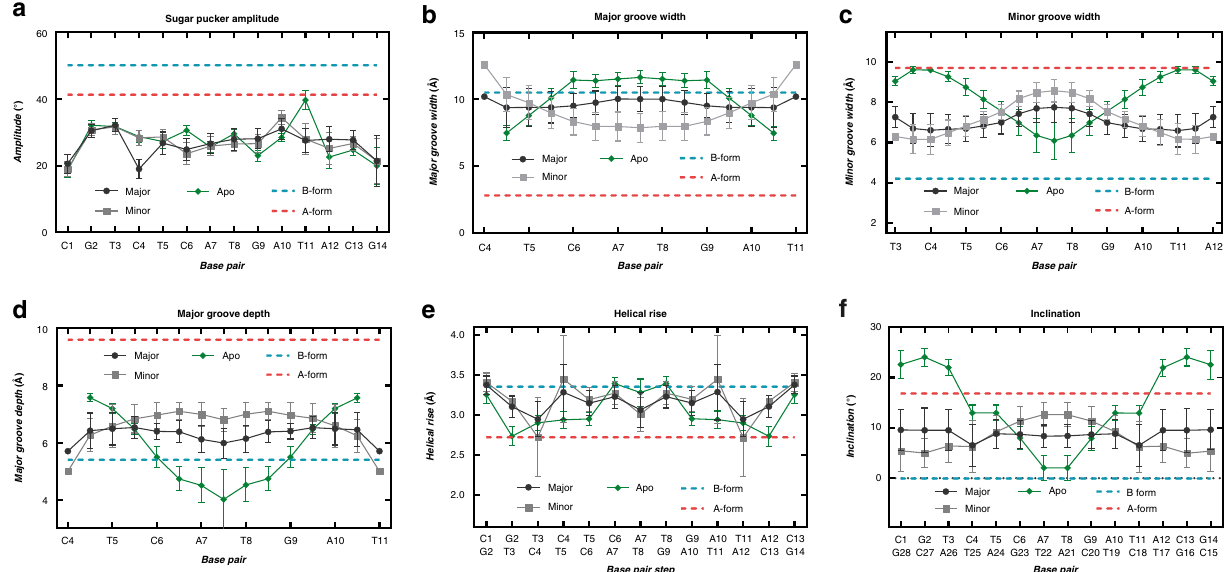
Fig. 6 Selected base pair and base pair step parameters of apo-, Hg II -bound major-, and Hg II -bound minor duplex structures. Parameters of apo (green diamonds, PDB 6RLS), Hg II -bound major (black circles, PDB 6FY6) and Hg II -bound minor (grey squares, PDB 6FY7) duplex structures were calculated using Curves + . 86 a Sugar pucker amplitude. b Major groove width. c Minor groove width. d Major groove depth. e Helical rise. f Inclination. The reference values for standard A- (red) and B-form (blue) duplex DNA were taken from (ref 86), which analyzed crystal structures of A-DNA (PDB 1d13 88 ) and B- DNA (PDB 1bna 66 ) dodecamers. Reported values represent the mean and standard deviation of the 20 lowest energy conformations for each structure. For additional analyses of base pair parameters see Supplementary Figs. 19 – 22. Source data are provided as a Source Data fi